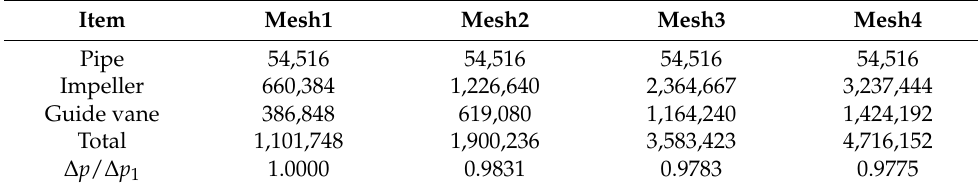
Figure 2. Mesh agreement: ( a ) whole domain; ( b ) around the tip clearance. Table 2. Independence test of the mesh number.